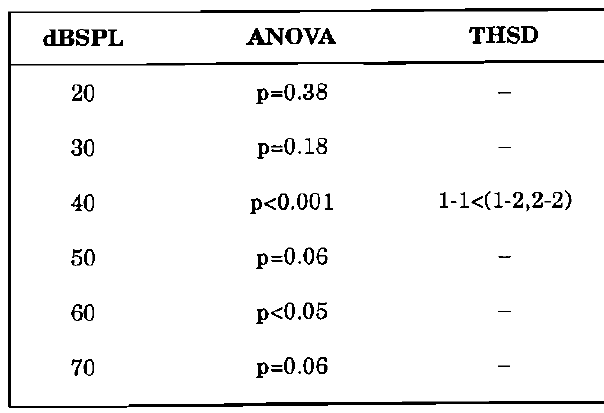
TABLE 2: ANOVA and Tukeys HSD results for SAE speakers' speech discrimination scores on e Tygerberg CID W22 wordlists for half-lists 1-1, 1-2, 2-1 and